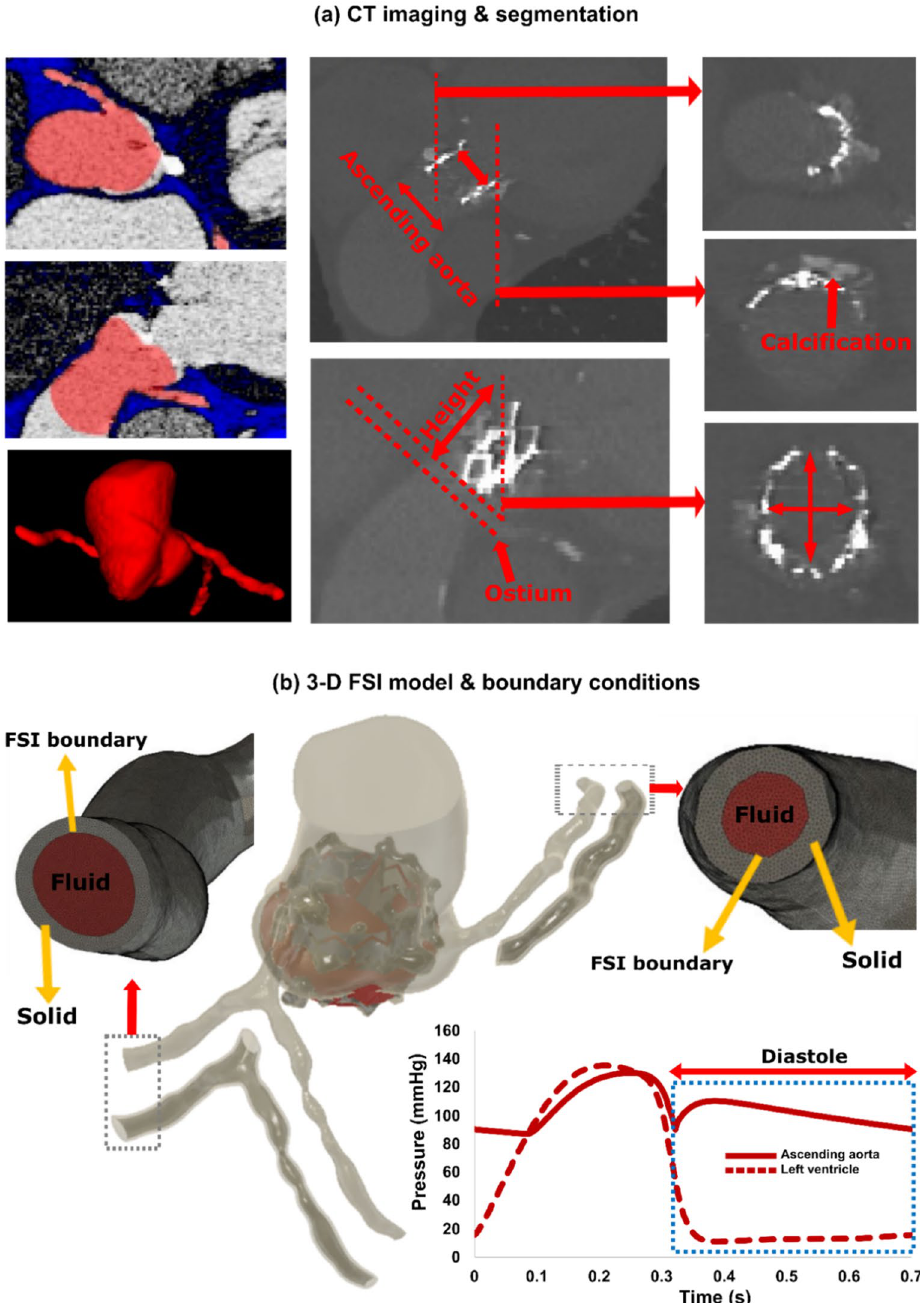
Figure 4. Reconstructed 3-dimensional geometry in a patient with AS who received TAVR using computed tomography, schematic diagram of LPM pressure boundary conditions and FSI. ( a ) CT views (coronal, sagittal and axial) of the ascending aorta, coronary branches, sinus of Valsalva and aortic valve for pre-TAVR (left column) and post-TAVR (middle and right column) as well as the segmentation process and geometry reconstruction; ( b ) computational domain and boundary condition. FSI simulations performed during diastole. Patient-specific LPM simulating the coronary perfusion pressure (ascending aorta pressure—LV diastolic pressure). This data was obtained from patient-specific imaged based lumped parameter model (Fig.